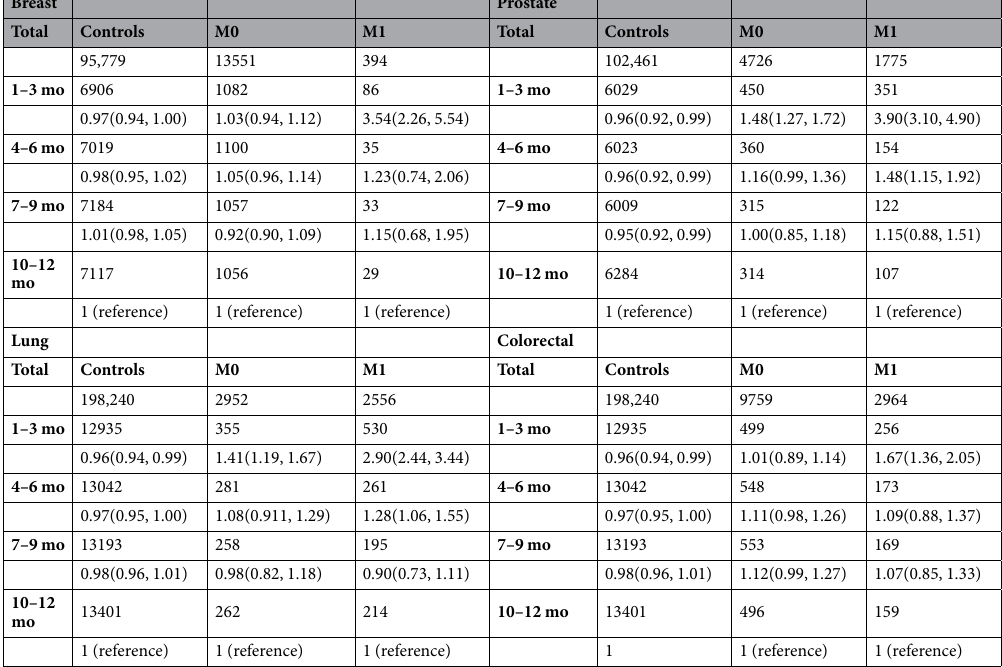
Table 2. Patterns NSAIDs use in the year prior to cancer diagnosis. The entries for each period in each table show the number of drug users in the period, the odds ratio (OR) and 95% confidence interval. The OR compares the drug use during each period with the 10–12 month period as reference. The analysis is adjusted for age, sex and education